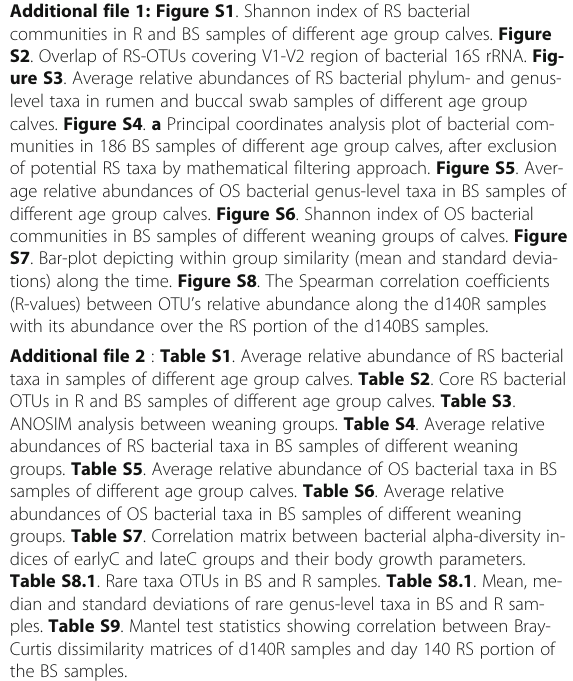
groups. Table S7 . Correlation matrix between bacterial alpha-diversity in- dices of earlyC and lateC groups and their body growth parameters. Table S8.1 . Rare taxa OTUs in BS and R samples. Table S8.1 . Mean, me- dian and standard deviations of rare genus-level taxa in BS and R sam- ples. Table S9 . Mantel test statistics showing correlation between Bray- Curtis dissimilarity matrices of d140R samples and day 140 RS portion of the BS